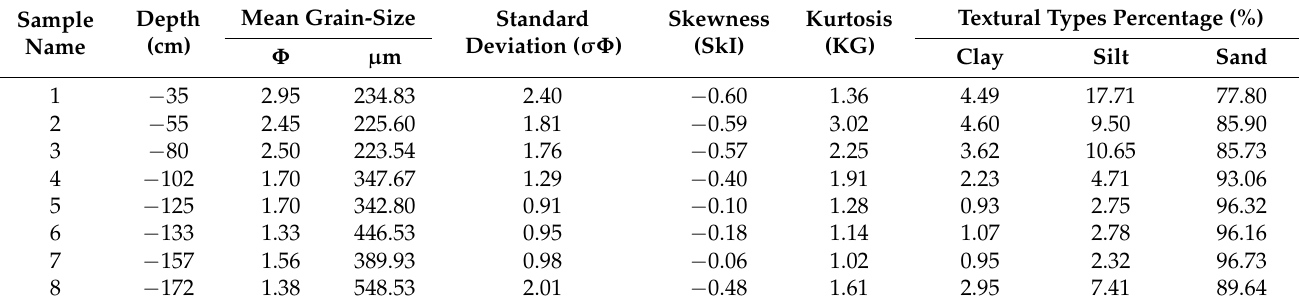
Table 3. Statistical parameters and textural type percentages from the T4 outcrop (see Figure